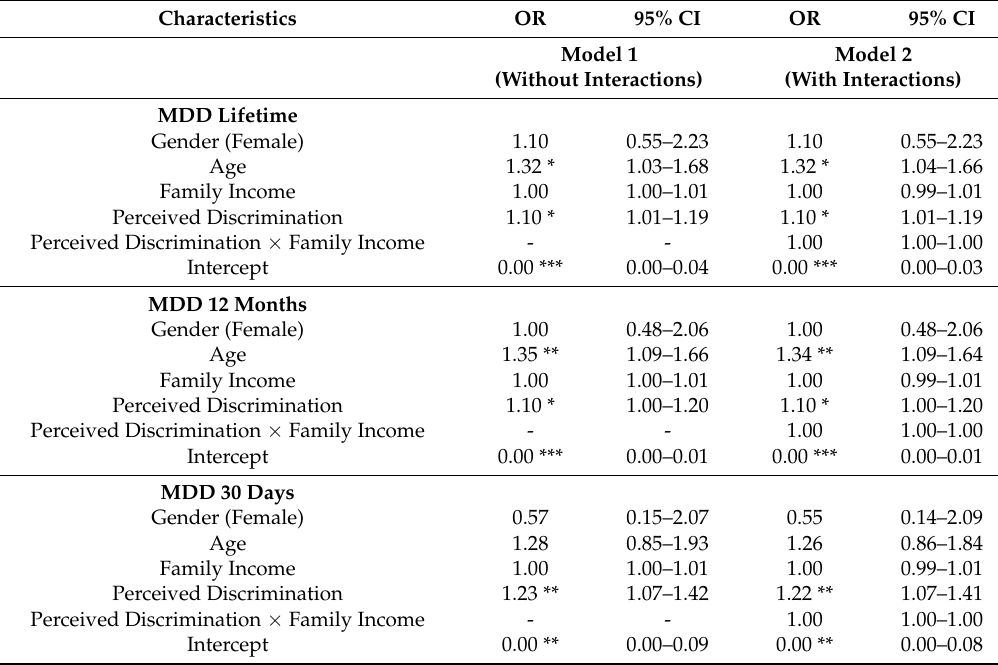
Table 5. Summary of logistic regressions on the multiplicative effects of perceived discrimination and family income on MDD ( n =